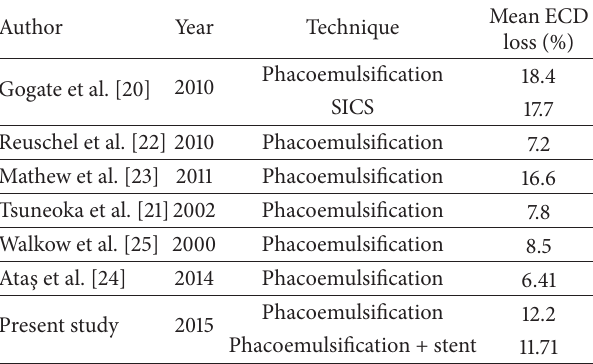
Table 4: Reported mean endothelial cell loss after cataract surgery (SICS:smallincisioncataractsurgery;ECD:endothelialcelldensity)